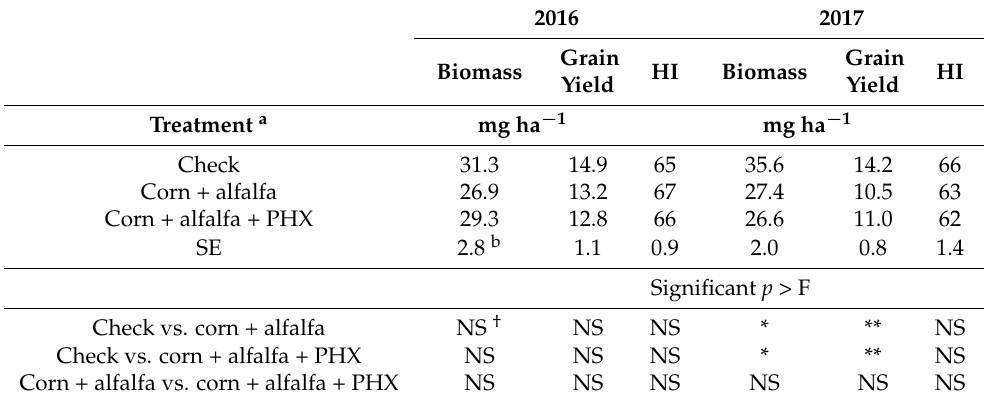
Table 5. Corn aboveground biomass, grain yield at 15.5% moisture and HI in response to alfalfa intercropping treatments for experiments started in 2016 and 2017 at Boone, IA,